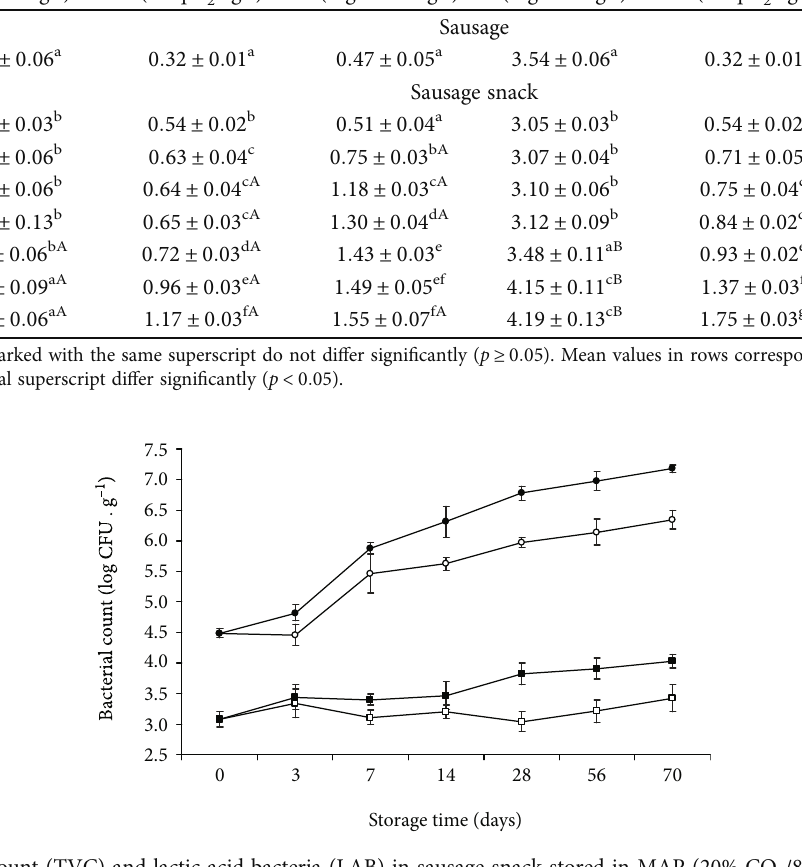
/80% N ) at 4 ° C and 20 ° C. 2 2